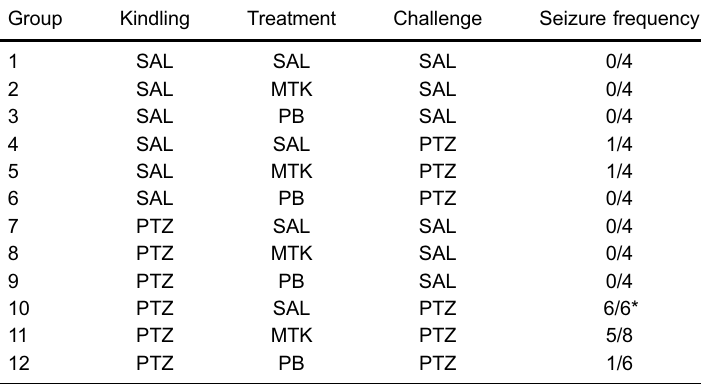
Table 1. Effect of montelukast (MTK) and phenobarbital (PB) on seizure frequency induced by pentylenetetrazol (PTZ) in kindled and non-kindled